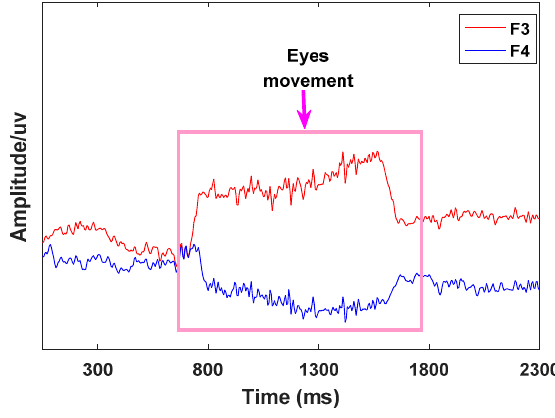
Figure 10. Eye movement signals.